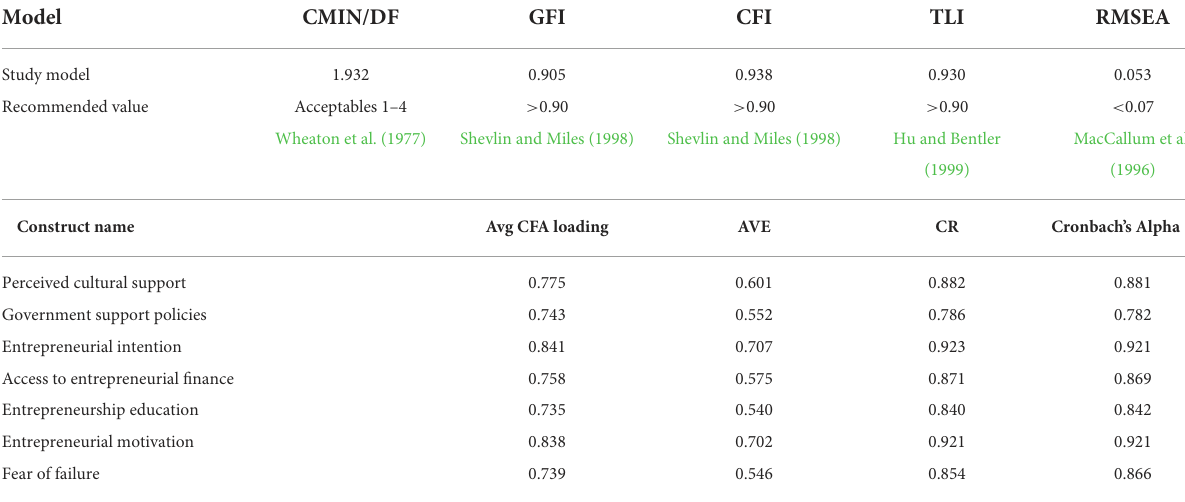
TABLE 2 CFA model fit indices, convergent validity, composite and Cronbach’s Alpha reliability.